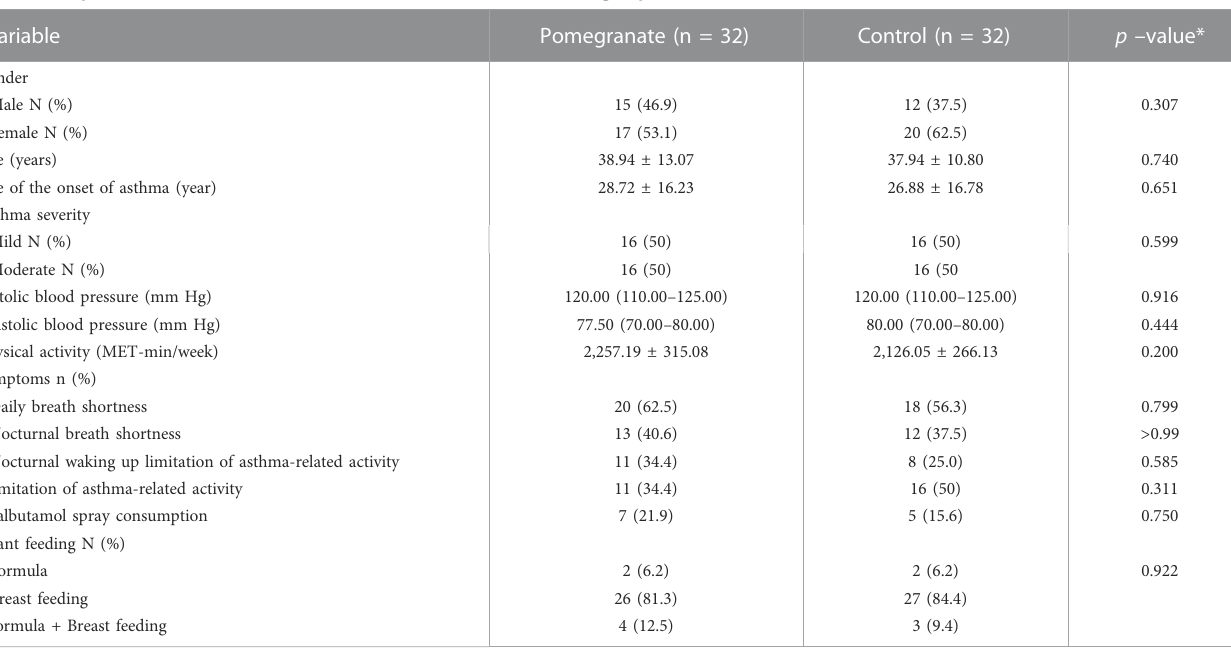
TABLE 1 Comparison of basic characteristics between intervention and control